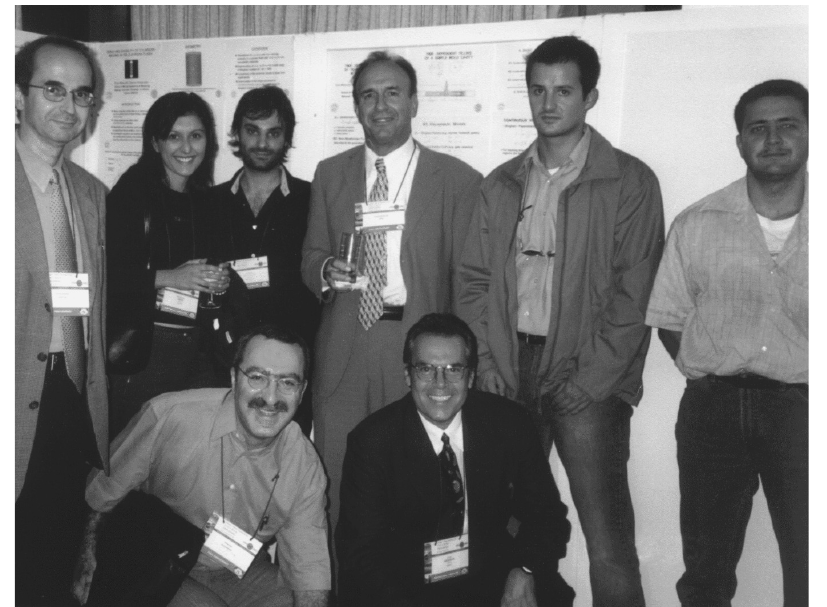
Figure 3 (right below): Traditional Greek dances during the banquet of PPS-2003 in a Greek